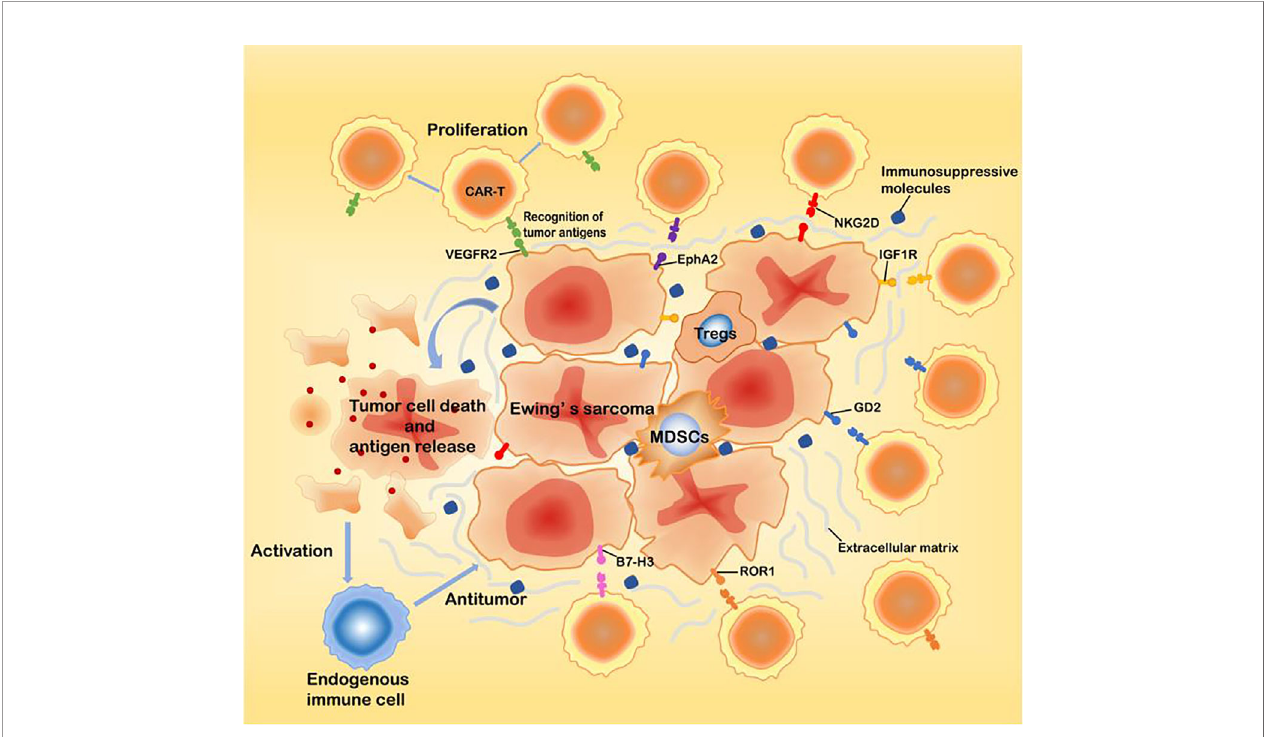
FIGURE 1 | The main targets of CAR-T cells for EWS